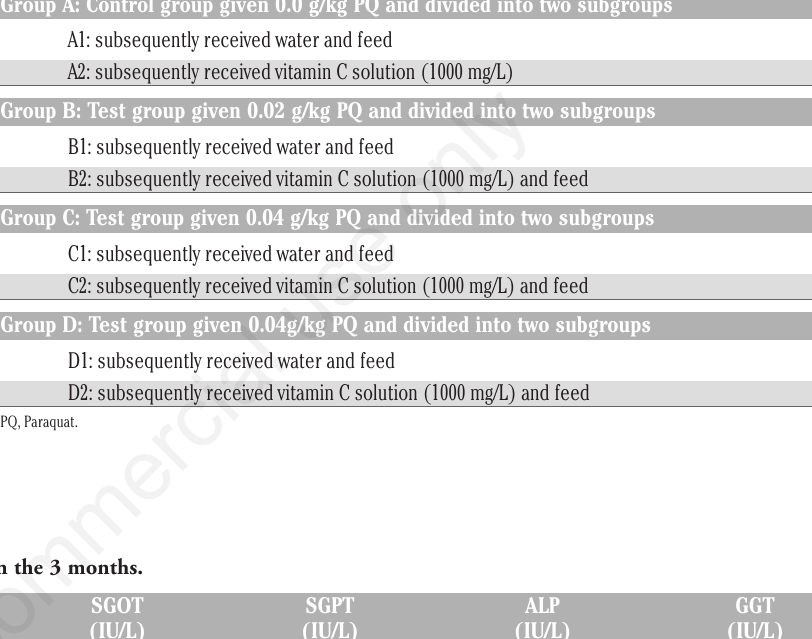
Table 1. Treatment chart for the subgroups. Group A: Control group given 0.0 g/kg PQ and divided into two subgroups